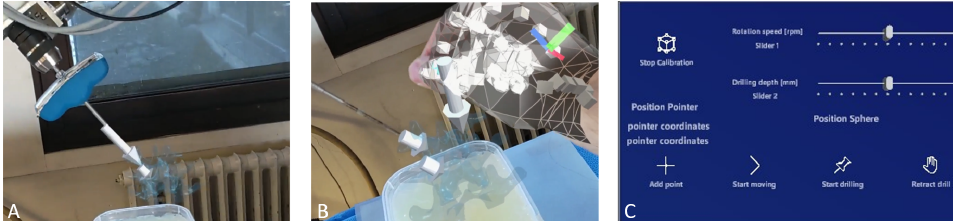
Figure 3. ( A ) The robot aligns the drill with the target arrow in AR; ( B ) Online adjustment of the surgical plan: a user can move and define the desired drilling position and orientation in the AR scene. ( C ) The GUI running in the HoloLens. By using the GUI panel in AR, the control command can also be sent to the robot controller for execution. The user could press the buttons or grab and move the sliders using hand